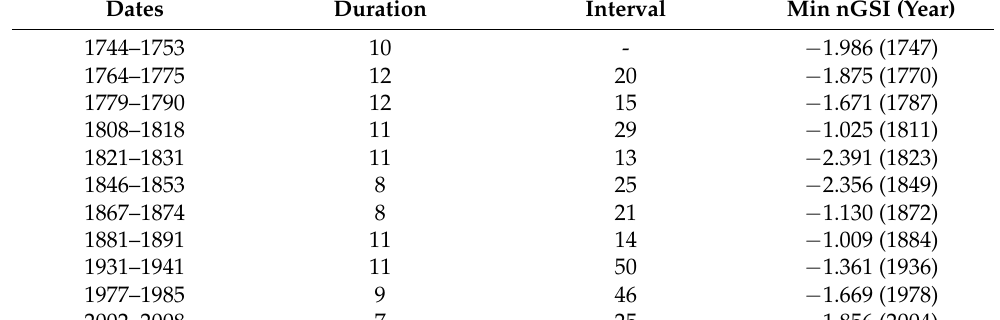
Table 2. Summary of outbreaks for the Kaibab Plateau. Return intervals are calculated as the time between the current and previous outbreak initiation.